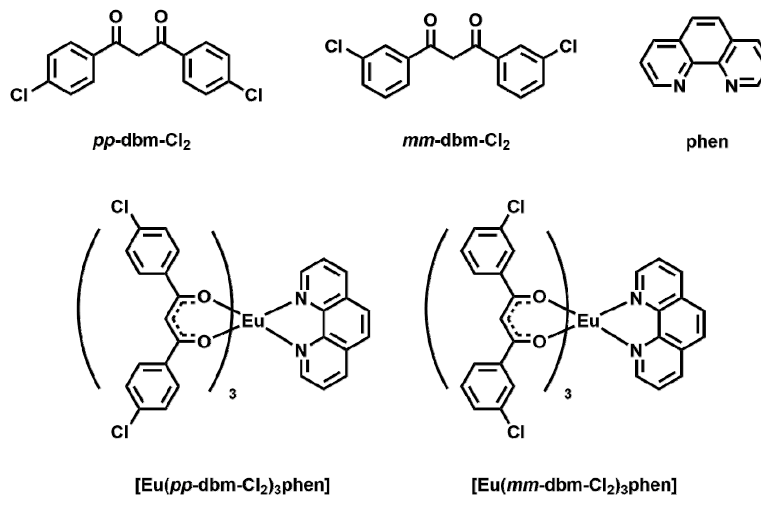
Figure 1. Compounds studied herein.